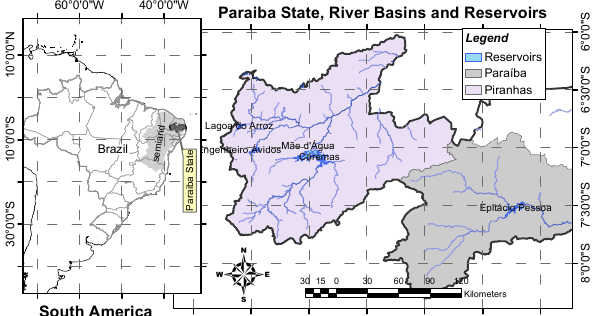
Figure 1. Study area: the State of Paraíba in the Brazilian semi-arid, the Paraíba and Piancó-Piranhas-Açu River Basins and the water